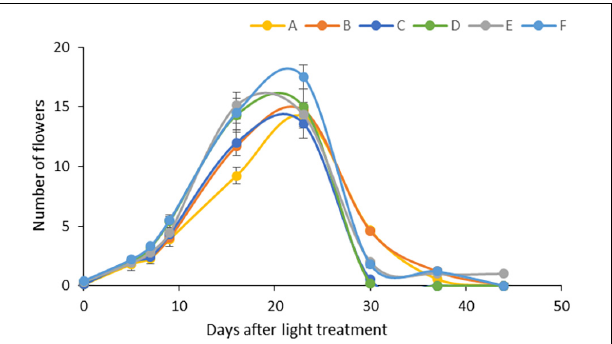
FIGURE 1 | Flowering under different light regimens: (A) Application of red and blue LEDs with a 95:5 ratio at moderate (300 µ mol m − 2 s − 1 ) light intensity; (B) utilisation of red and blue LEDs with a 80:20 ratio at (300 µ mol m − 2 s − 1 ) light intensity; (C) a wide spectrum with an average proportion of 65:20:15 of red:green:blue at moderate (300 µ mol m − 2 s − 1 ) light intensity: (D) a wide spectrum supplemented with far-red application in an average proportion of 65:20:15:0.6 of red:green:blue:far-red at moderate (300 µ mol m − 2 s − 1 ) light intensity; (E) a wide spectrum supplemented with far-red application in an average proportion of 65:20:15:0.6 of red:green:blue:far-red at high (500 µ mol m − 2 s − 1 ) light intensity; (F) a wide spectrum supplemented with far-red and blue light application in an average proportion of 64:20:16:0.6 of red:green:blue:far-red at high (500 µ mol m − 2 s − 1 ) light